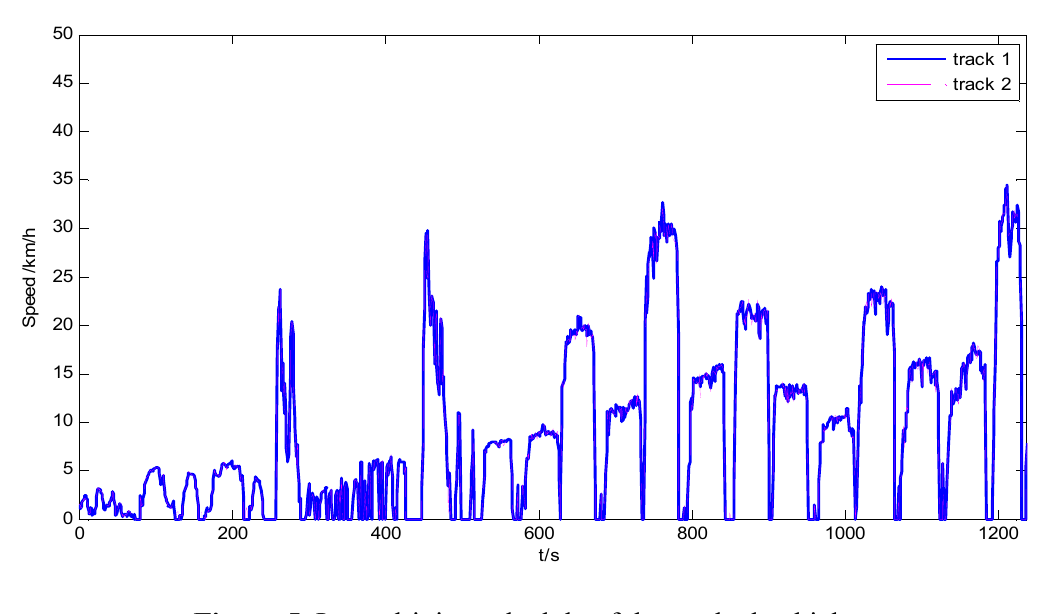
Figure 5. Long driving schedule of the tracked vehicle.